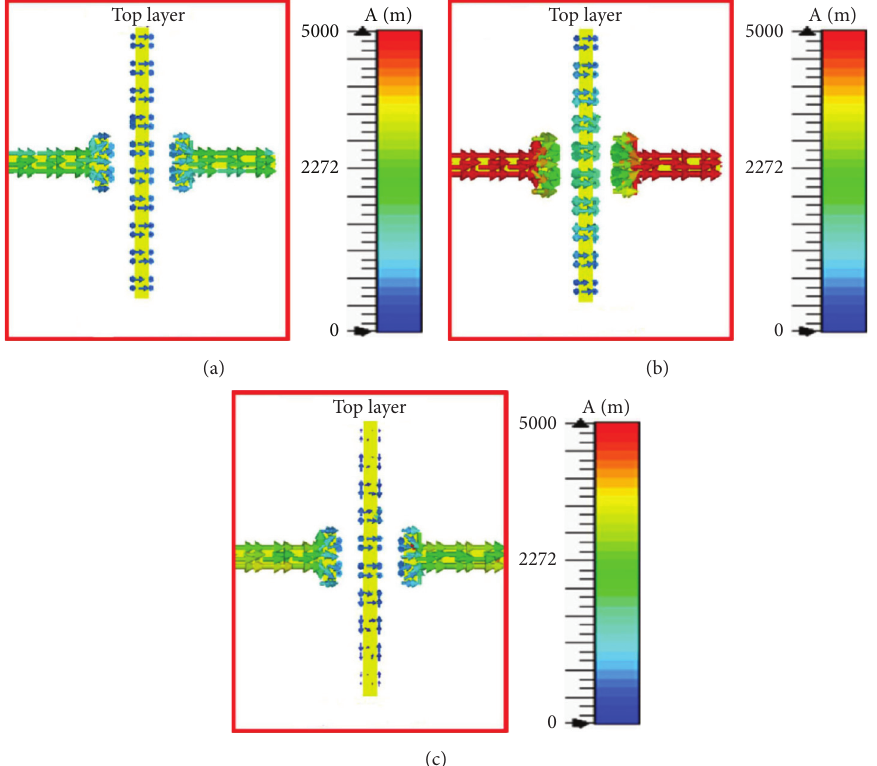
Figure 4: Surface current distribution for the device when VO (c)